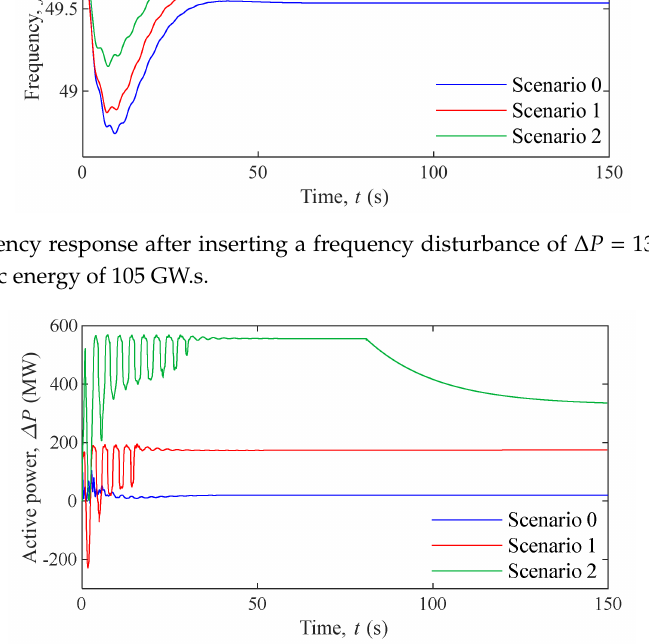
Figure 15. Total active power contribution of synchronous generators (Scenario 0), synchronous generators, DFIM and CFSM (Scenario 1) and synchronous generators, DFIM, CFSM and BESS (Scenario 2) in the year 2040.